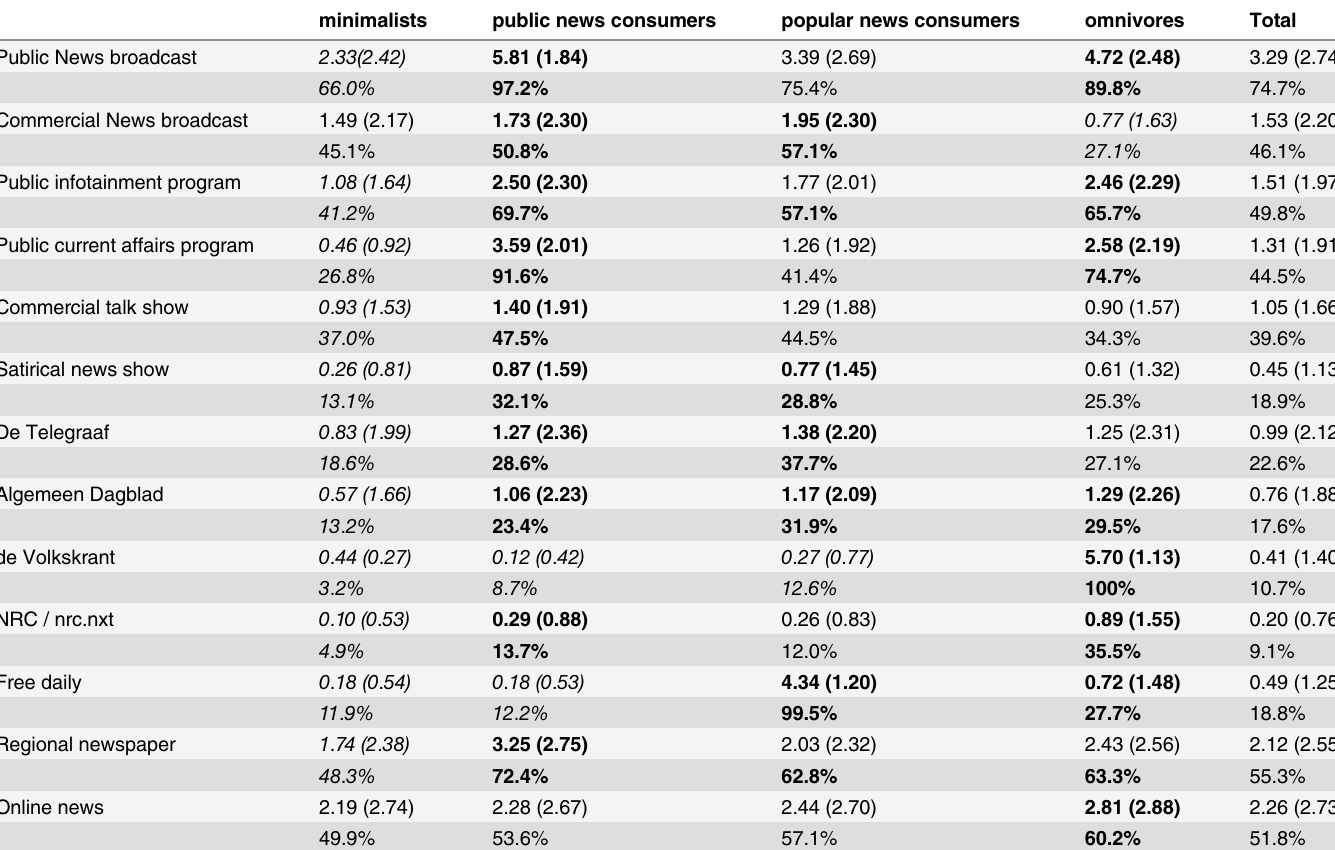
Table 2. Media exposure per profile: average number of days per